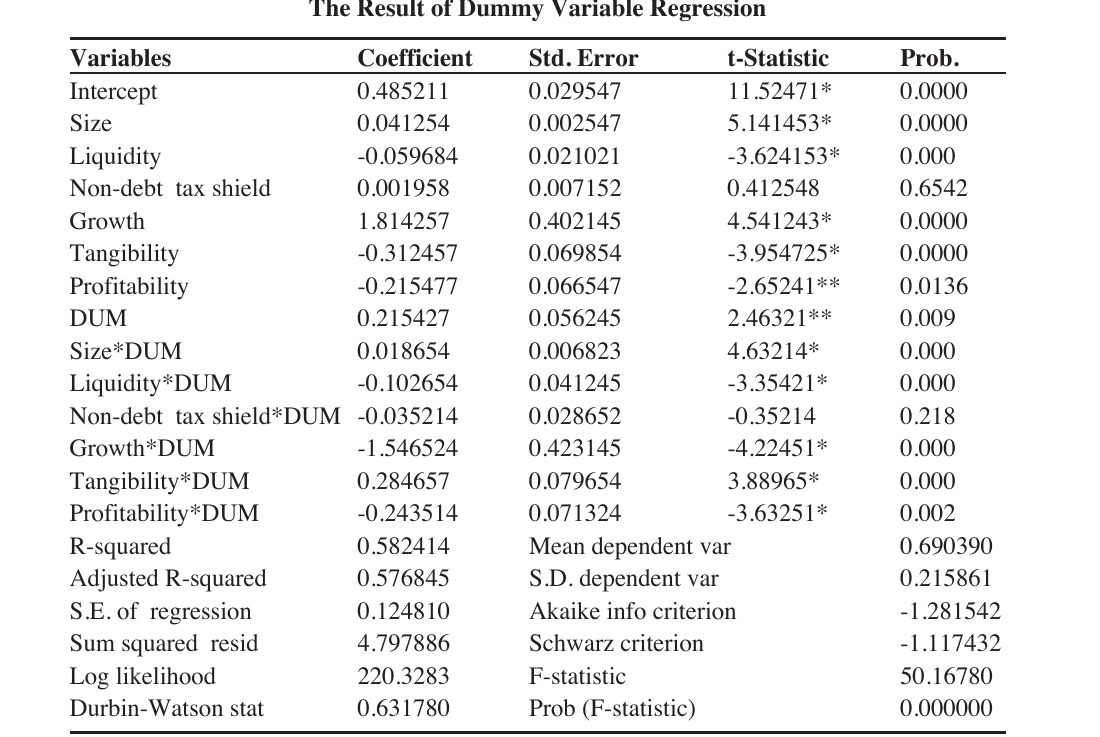
The Result of Dummy Variable